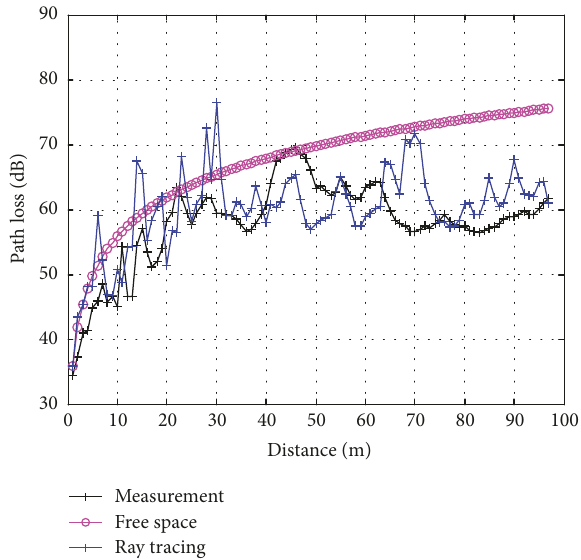
Figure 4: Path loss versus distance for measurement, ray tracing, and free space results.